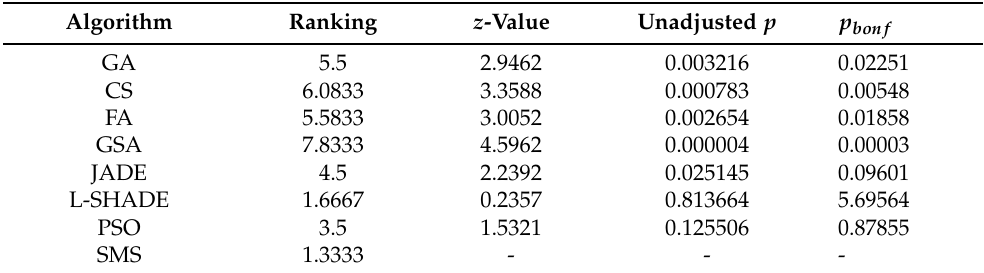
Table 6. Statistical analysis of the SMS algorithm for the PM 2.5 concentration time series compared to other heuristic optimization algorithms.